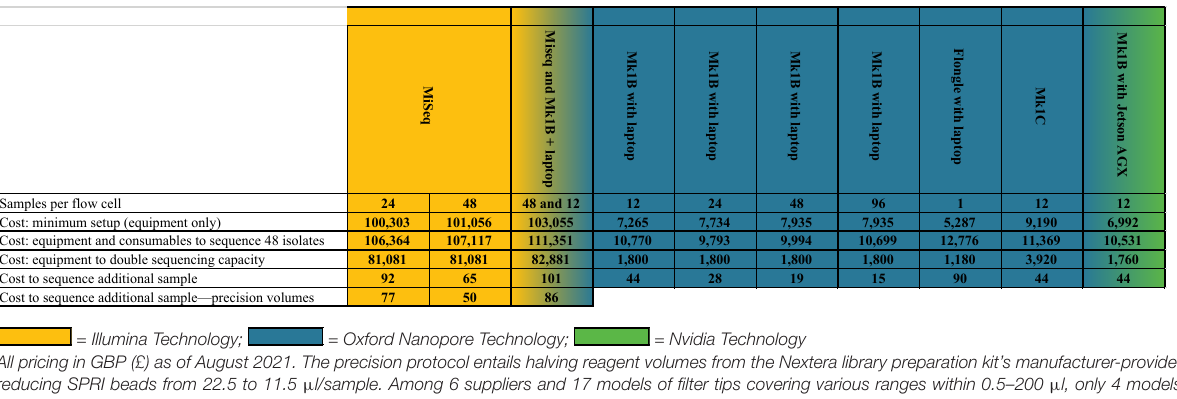
TABLE 6 | A cost analysis of MiSeq, Mk1B, and Mk1C sequencing using various flow-cell